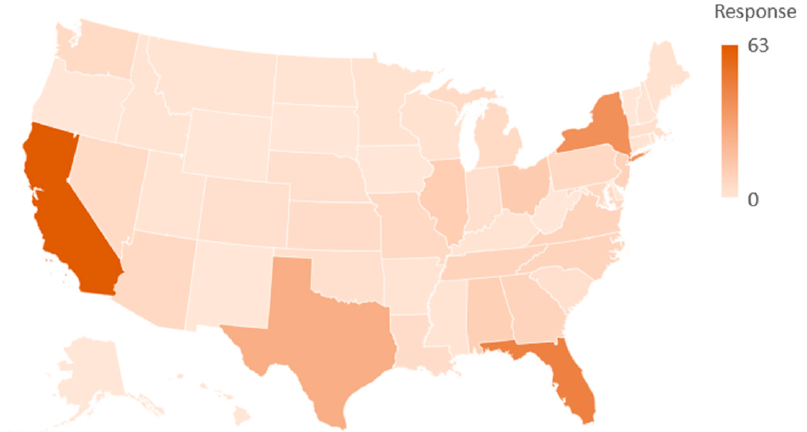
Figure 2. Response distribution across the US .